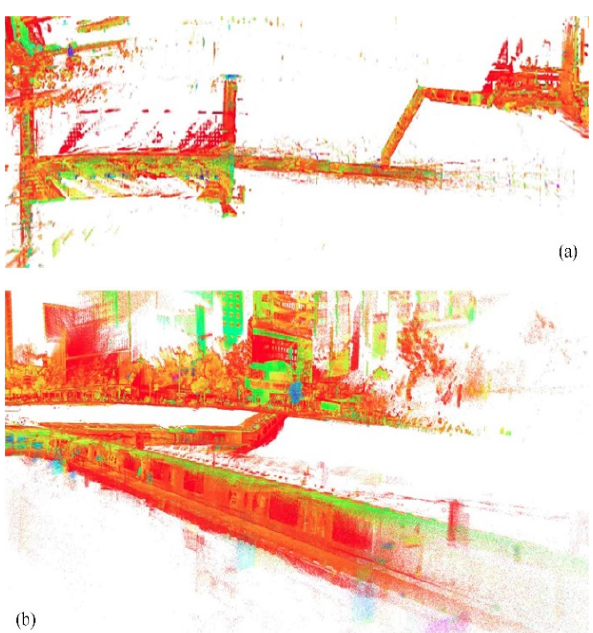
Figure 7 Walking in the metro station. (a) overview of the whole metro station. (b) point clouds inside the metro station